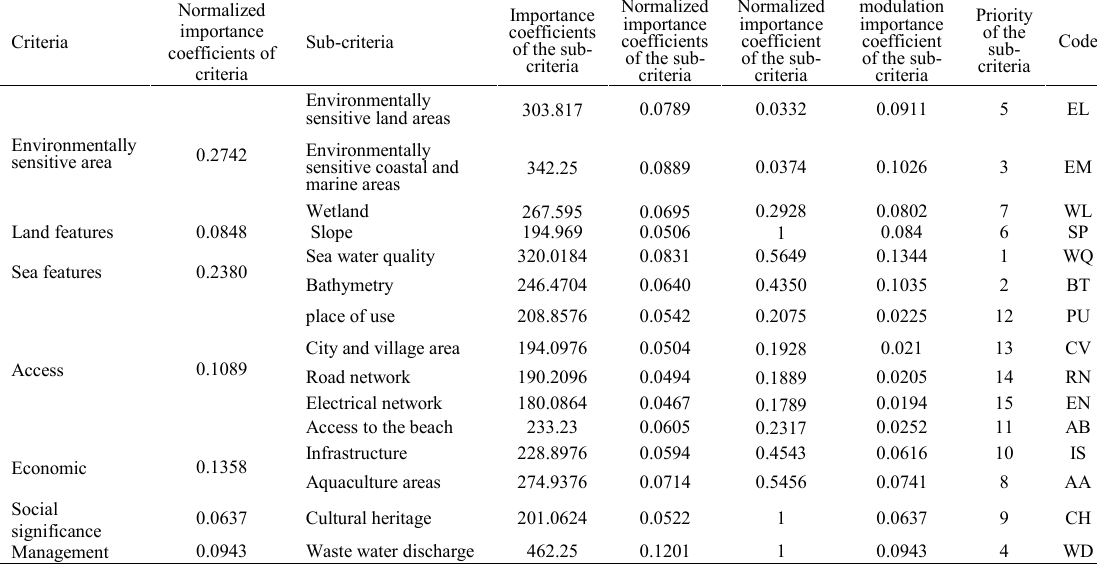
Table 3: Calculating normalized importance coefficients of criteria and modulation importance coefficient of sub-criteria